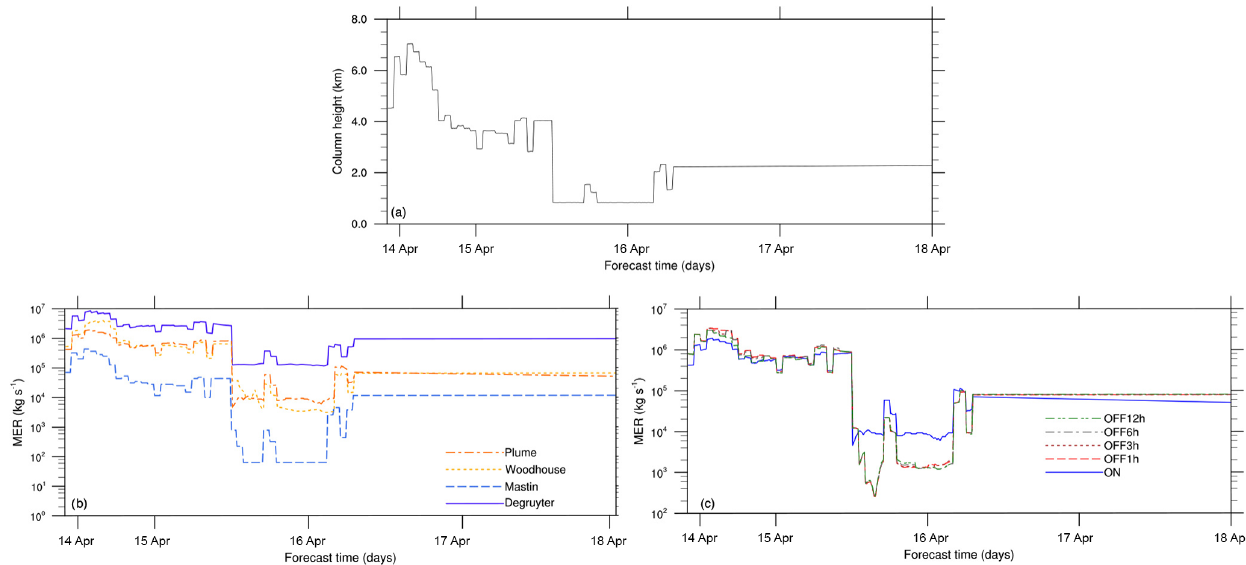
Figure 5. Eruption source parameters for the 2010 Eyjafjallajökull application: (a) column height fluctuation over time; (b) resulting MER over time considering different plume parameterizations (FPLUME – Folch et al., 2016; Woodhouse – Woodhouse et al., 2013; Mastin – Mastin et al., 2009; Degruyter – Degruyter and Bonadonna, 2012); (c) resulting MER for each coupling strategy (meteorology coupled online or with intervals of time of 1, 3, 6, and 12h) with the Degruyter option only.